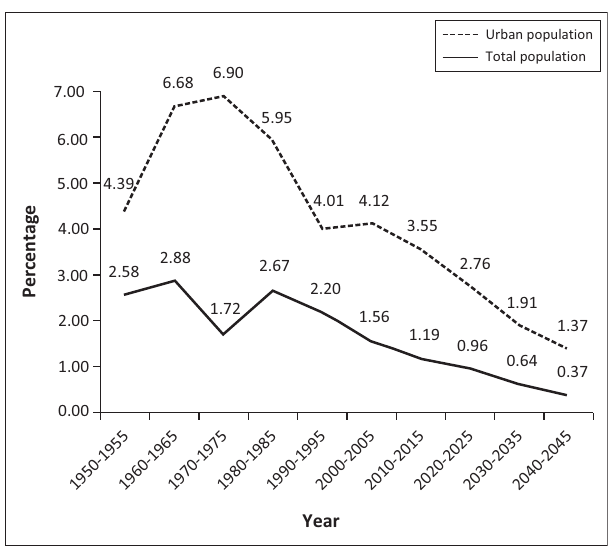
FIGURE 4: Average annual rate of change of total population and urbanisation (in per